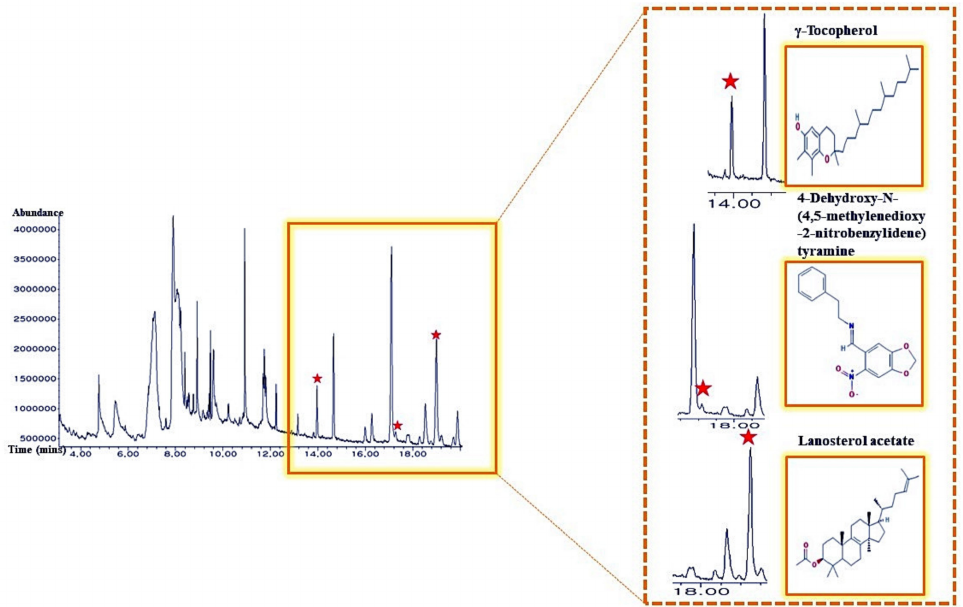
Figure 2. A typical GC-MS chromatogram of methanolic extract of M. alba L. leaves and indication of 3 main